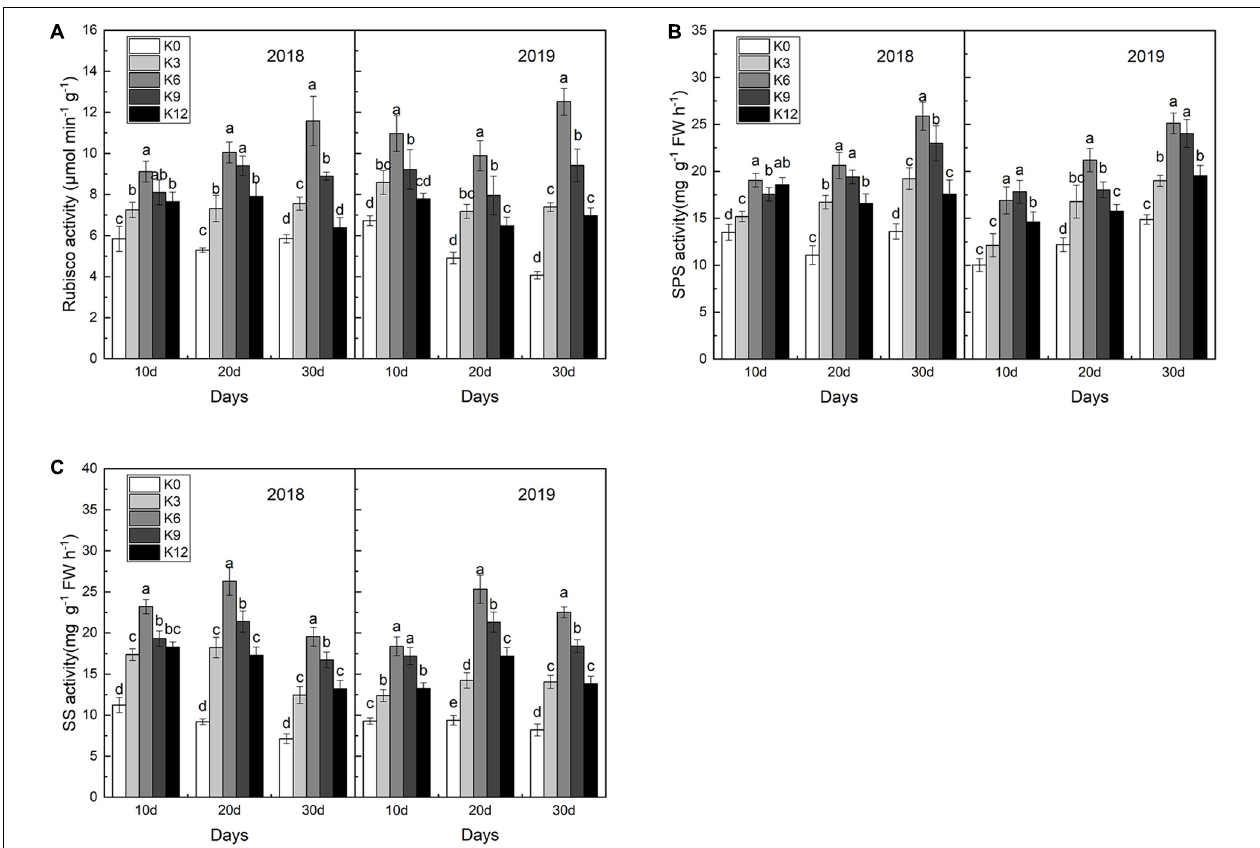
FIGURE 3 | Rubisco (A) , SPS (B) , and SS (C) activities in the leaves of M9T337 seedlings treated with K0 (0 mM K + ), K3 (3 mM K + ), K6 (6 mM K + ), K9 (9 mM K + ), or K12 (12 mM K + ) in 2018 and 2019. Each treatment had three biological replicates and the assays were repeated three times. Vertical bars indicate ± SD ( N = 3). Different letters indicate statistically significant differences ( P <